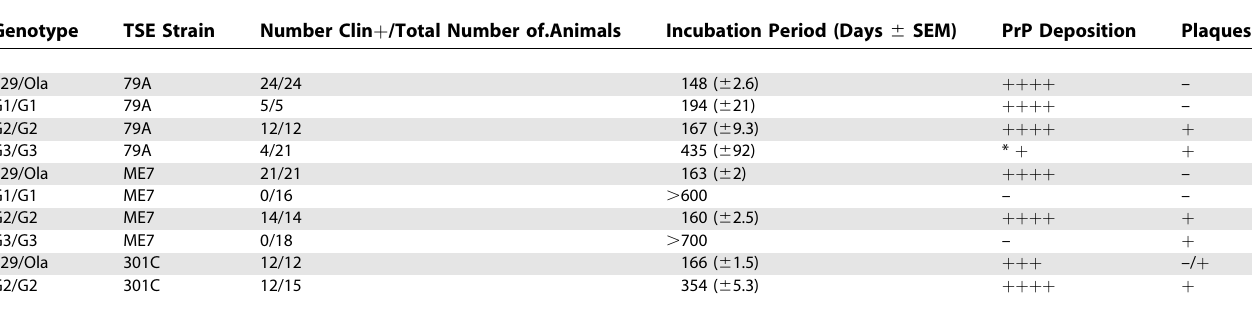
Table 1. Incubation Periods of Wild-Type and Glycosylation Mutant Mice Infected with TSE Strains